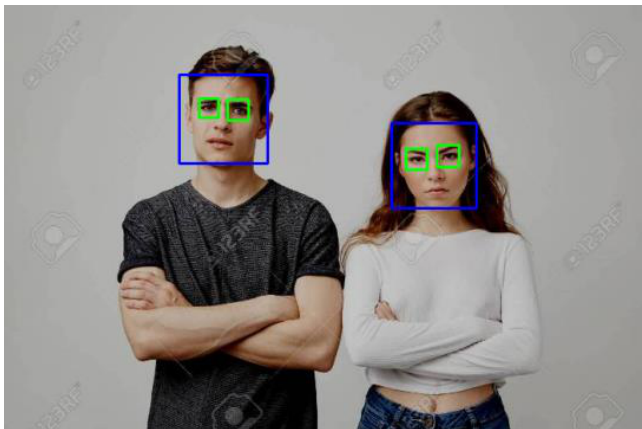
Figure 38. After decreasing the brightness of Figure 28.